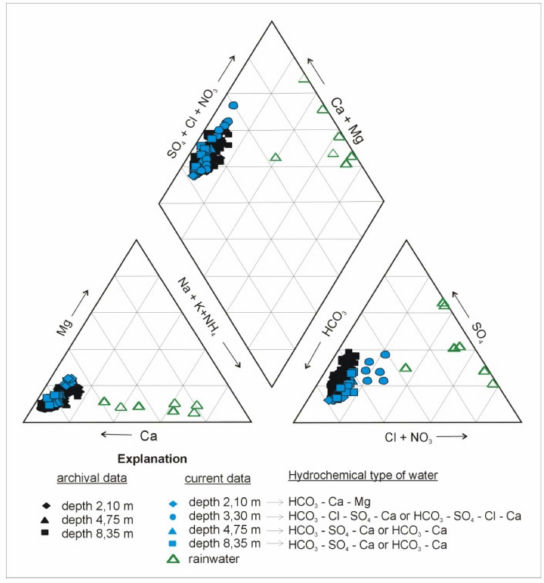
Figure 3. Piper diagram showing chemical composition of groundwater in vertical profile of the Po˙zary aquifer. Rain water are plotted for reference. Archival records refer to groundwater monitoring period from June 1999 to December 2001